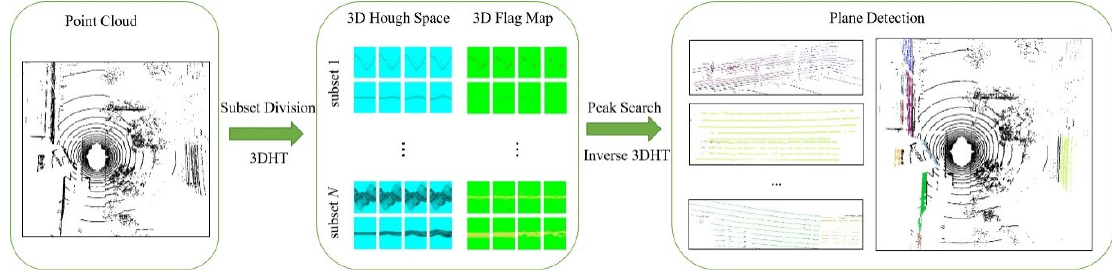
Figure 1. Flowchart of the fast planar detection system.